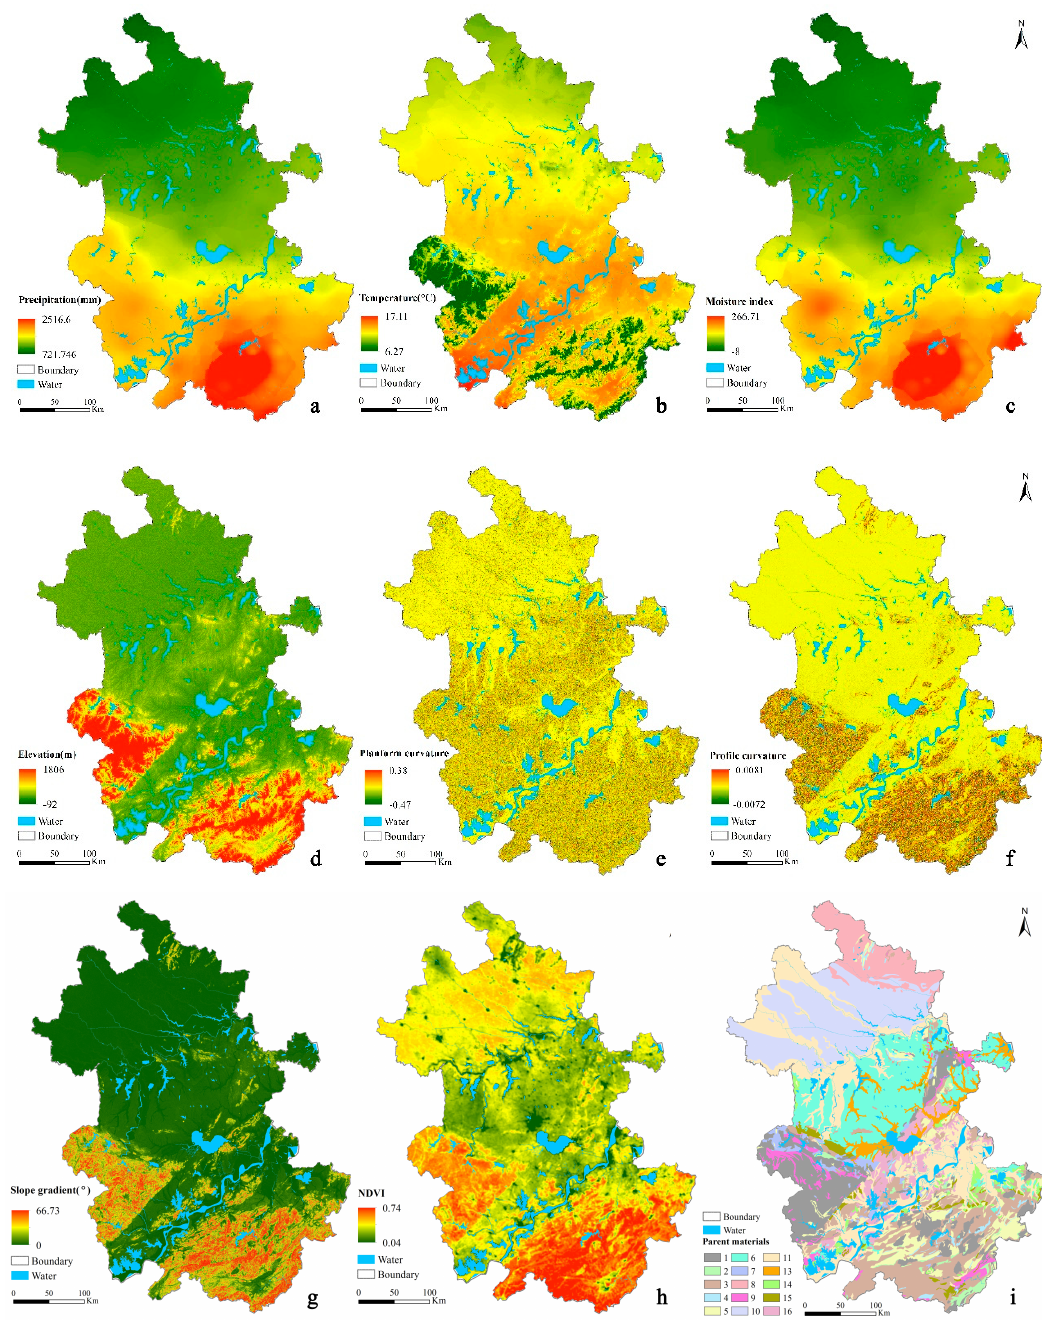
Figure 2. Maps of environmental covariates in the study area: ( a ) annual averaged precipitation; ( b ) annual averaged temperature; ( c ) moisture index; ( d ) elevation; ( e ) planform curvature; ( f ) profile curvature; ( g ) slope gradient; ( h ) NDVI; ( i ) parent material (legend of parent material: 1. acid plutonic, volcanic or metamorphic rocks, 2. pyroclastic rocks, 3. Sandstone, 4. psammite or arenite, 5. calcareous rocks, 6. fine-silt and sandy clay, 7. intermediate volcanic and plutonic rocks, 8. silt clay and clayey silt interbed, 9. basic metamorphic, volcanic or plutonic rocks, 10. fine-silt and clayey silt, 11. fine-silt and sandy gravel soils, 13. sandy clay, 14. wormlike boulder clay or gravelly clay, the gravel has abrasion faces and striations, 15. psephite or rudite, 16. top with silt clay and bottom with gravelly medium-fine sandy, silt